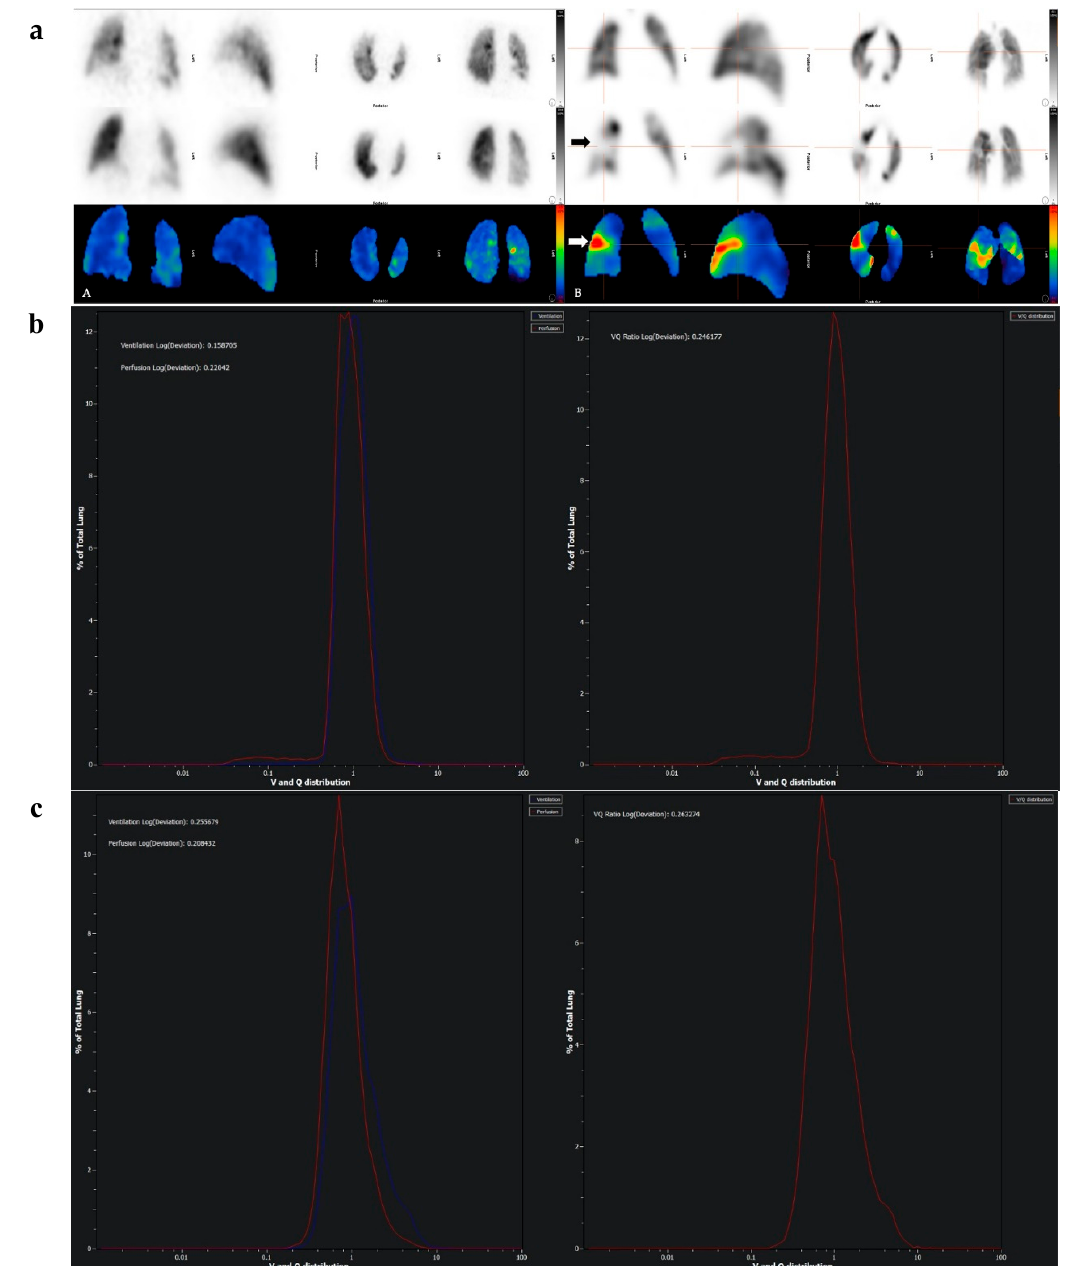
Figure 3. Lung VQ SPECT quantitative analysis and display from Hermes Medical Solutions’ Hybrid Viewer software. Objective analysis of SPECT scintigraphy has a high diagnostic accuracy in patients with suspected pulmonary embolism. ( a ): Panel A: Normal. Panel B: Acute pulmonary embolism (block arrows); Top row = ventilation SPECT reconstruction; middle row = perfusion SPECT reconstruction, corrected for counts remaining from the ventilation study by subtraction; bottom row = 3-D V/Q ratio image created by dividing the ventilation counts by the perfusion counts for each voxel, displayed on a 0–6 scale. In the bottom row, red represents high V/Q values, indicating a mismatch, blue represents low V/Q values, indicating that ventilation and perfusion are matched in that region. ( b ) Normal and ( c ) Acute pulmonary embolism (same patients from ( a )). Histograms of the V and Q voxel-wise frequency distributions (left hand side) and V/Q voxel-wise frequency distribution (right hand side) plotted against the V/Q ratio. The wider the peaks and the more different the V and Q frequency distribution curves, the higher the probability of PE.